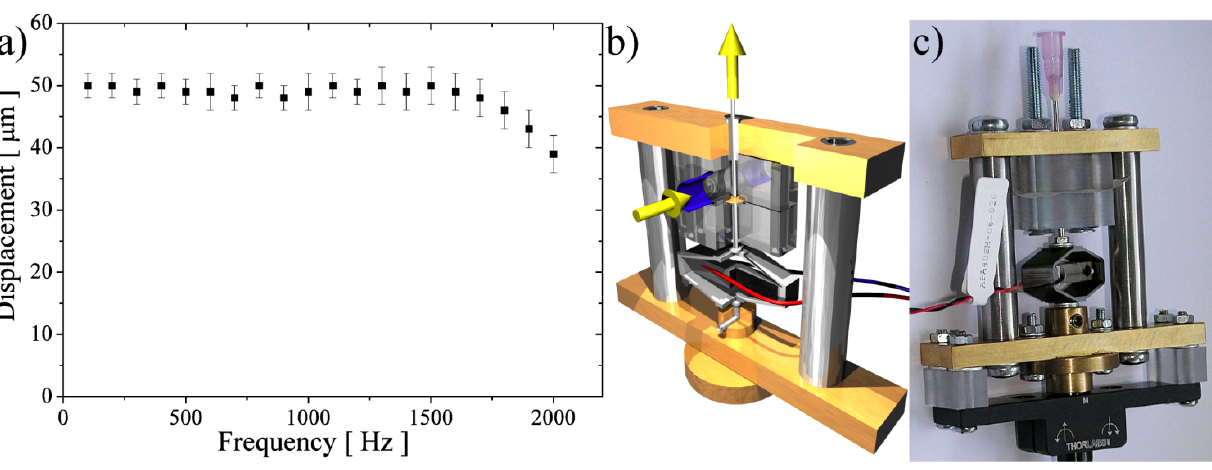
Figure 5. ( a ) Measured displacement of the loaded APA40SM actuator versus the ); ( b ) The piezoelectric valve scheme (the arrows frequency of the driving signal (150 V p-p show fluid inlet and outlet); ( c ) The real piezoelectric valve constructed in our microfluidic